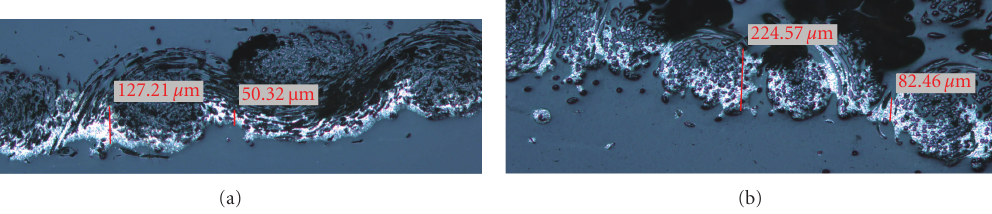
Figure 3: Cross-sections of antennas on Fabric (A) and Fabric (B), magnification is × 20. The light part in the figure is the ink film, and the dark part is the fibre structure of the fabric.